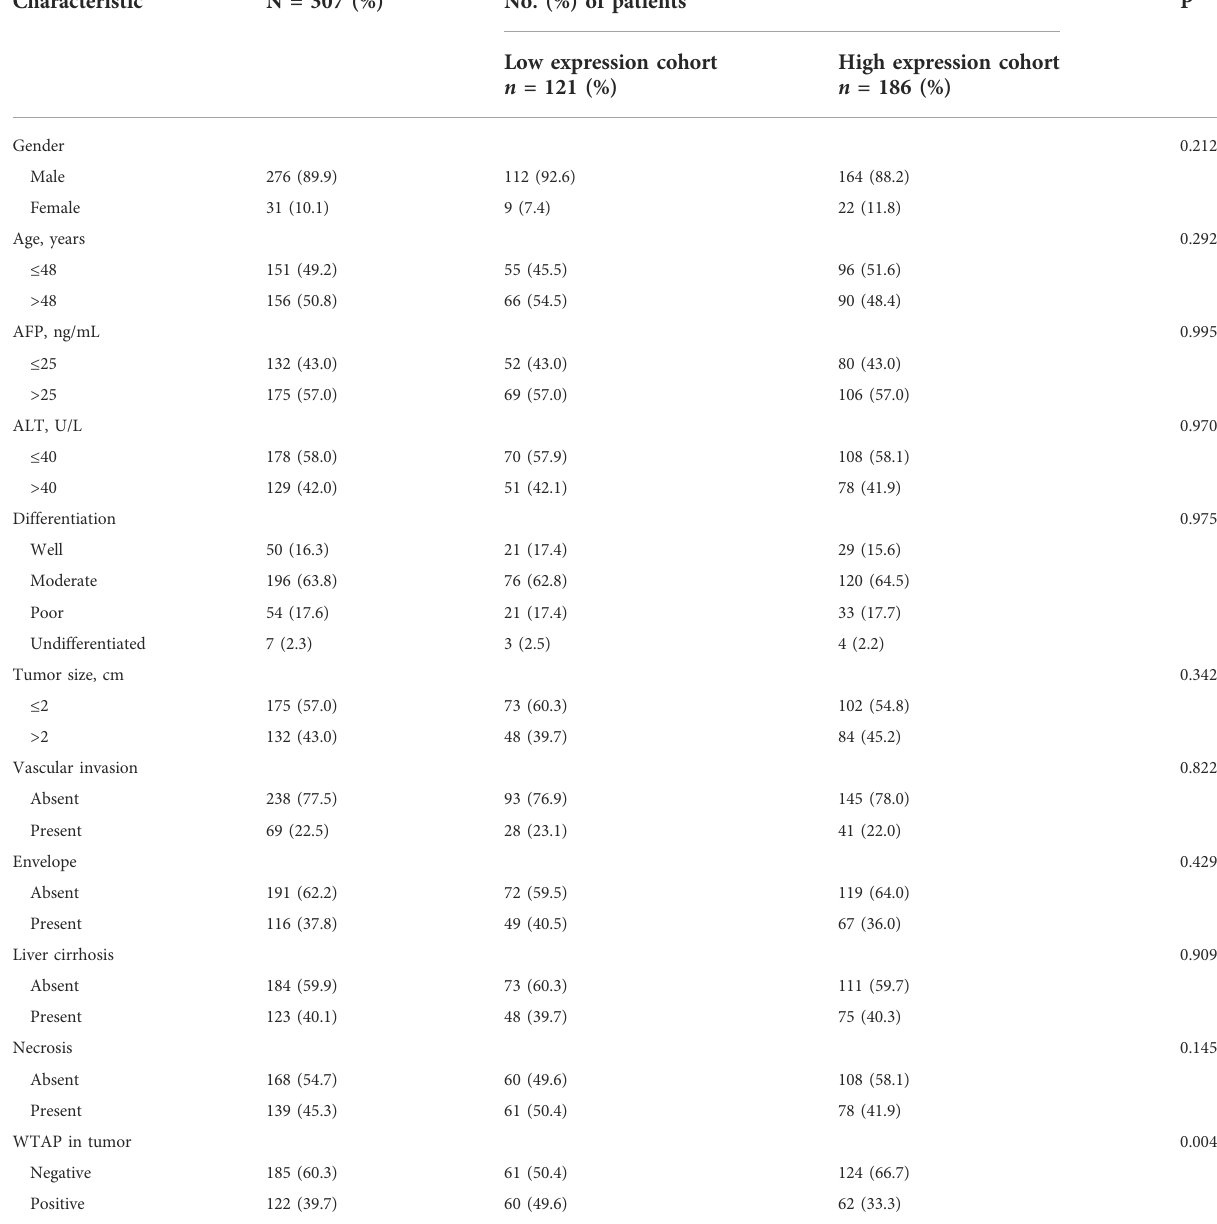
TABLE 1 Baseline patient characteristics according to expression pro fi le of WTAP in PANLT a .